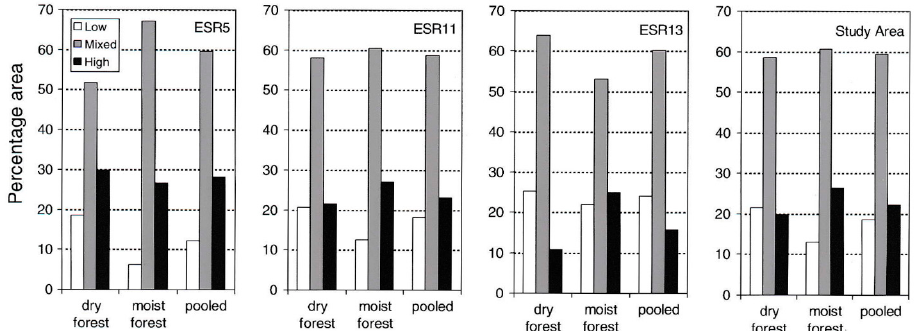
Figure 4. The proportions of the pre-management-era forest area (ha) by forest potential vegetation type in low-, mixed-, and high-severity fire (corresponding with percent canopy mortality values of ≤ 20%, 20.1–69.9%, and ≥ 70%, respectively) of Ecological Subregions 5, 11, and 13 and the study area. Comparisons are shown for the dry and moist forest potential vegetation types and pooled (sum of dry and moist). Note the dry-forest columns in each subregion and in the study area as a whole. Reprinted from Hessburg et al. ([11] Figure 5 part) with permission from Springer Nature.